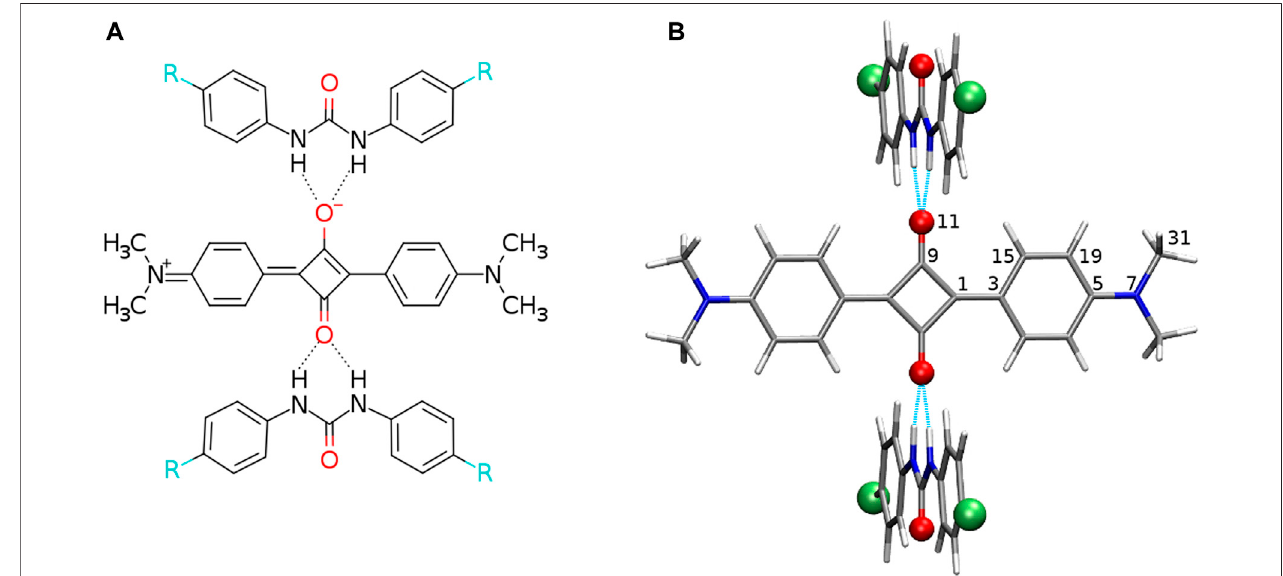
FIGURE 1 | (A) Structural formula of the analyzed hydrogen-bonded squaraine complex with 2 N,N ′ -diphenylurea molecules (R denotes electron-donating or electron-accepting functional groups) and (B) exemplary optimized structure with the urea plane perpendicular to the squaraine plane (red balls placed for oxygen or sulfur atoms, green balls depict the protons substituted with electron-donating or electron-accepting functional groups, and intermolecular hydrogen bonds are shown in cyan dashed line). Atom numbering for the symmetrical and unique atoms is given.